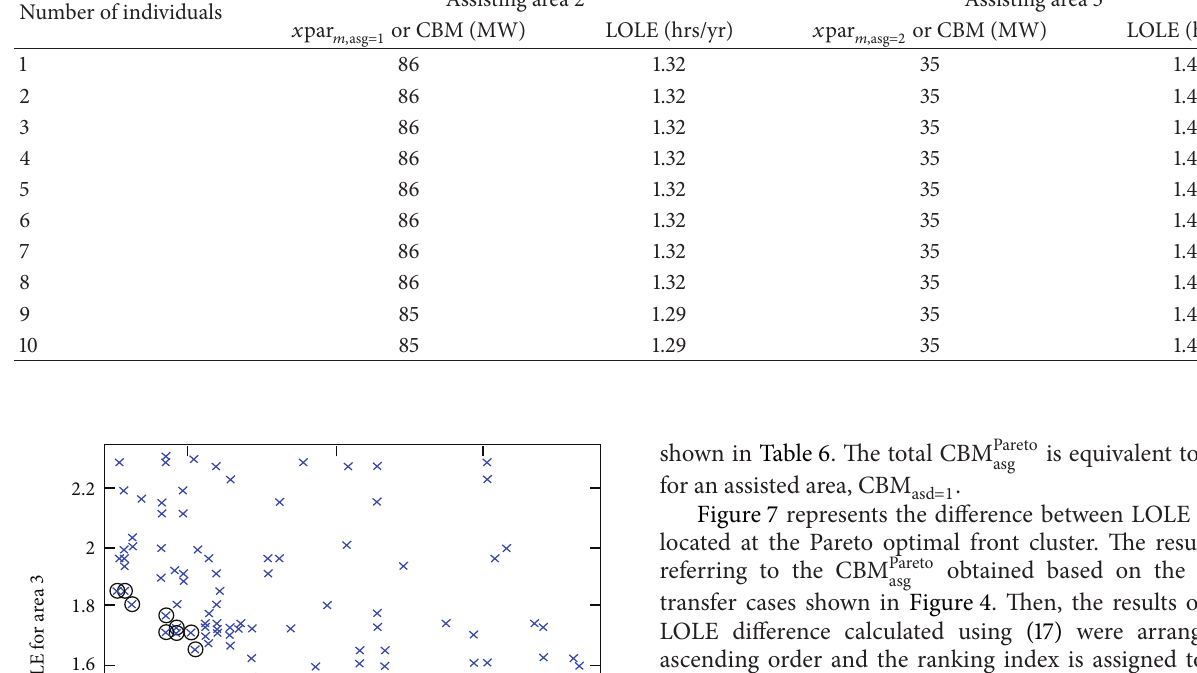
Table 4: Final population for the assisting areas 2 and 3 based on one run of EP optimization process. Number of individuals